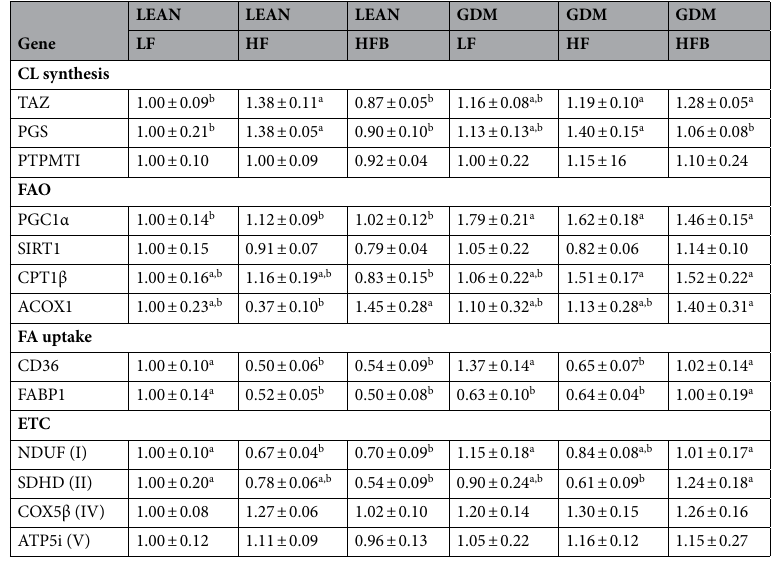
Table 5. PCR analysis of the heart. mRNAs were measured from the heart of offspring following 12-weeks of the indicated diet (LF, HF, HFB). Values are means ± SEMs (n = 7), means without a common letter differ,